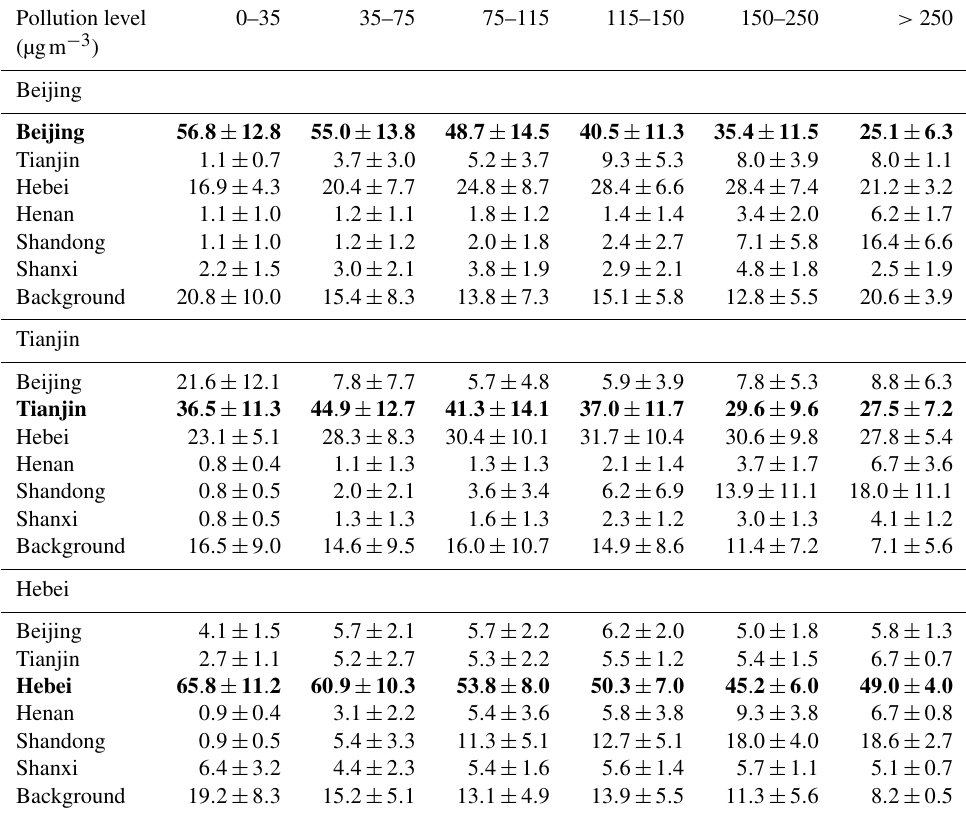
Table 2. Average PM 2 . 5 contributions (%) in Beijing, Tianjin, and Hebei under different pollution levels from local sources, the other five provinces, and the background source from 5 December 2015 to 4 January 2016. The bold font indicates the local